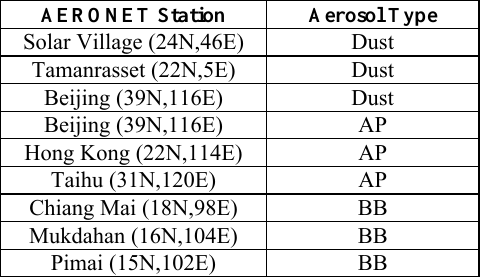
Table 1. The sites of AERONET station with main aerosol